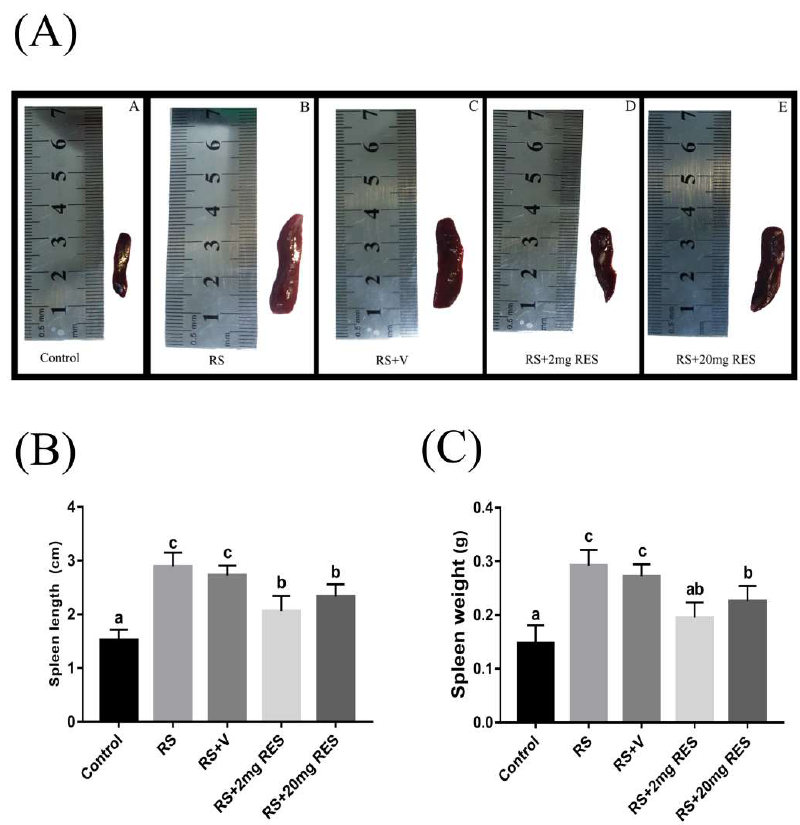
Figure 8. Resveratrol and restraint stress e ff ects on spleen size ( A ), length ( B ), and weight ( C ) of non-stressed mice (Control), restraint-stressed mice (RS), restraint-stressed mice with vehicle (RS + V), and restraint-stressed mice treated with 2 mg / kg body weight resveratrol (RS + 2 mg RES), and restraint-stressed mice treated with 20 mg / kg body weight of resveratrol (RS + 20 mg RES). Each bar in the given graphs represents the mean ± SEM (n = 10). Statistical di ff erences were determined by 1-way ANOVA followed by Tukey’s multiple comparison test. Di ff erent superscript letters represent significant di ff erences among groups ( p <